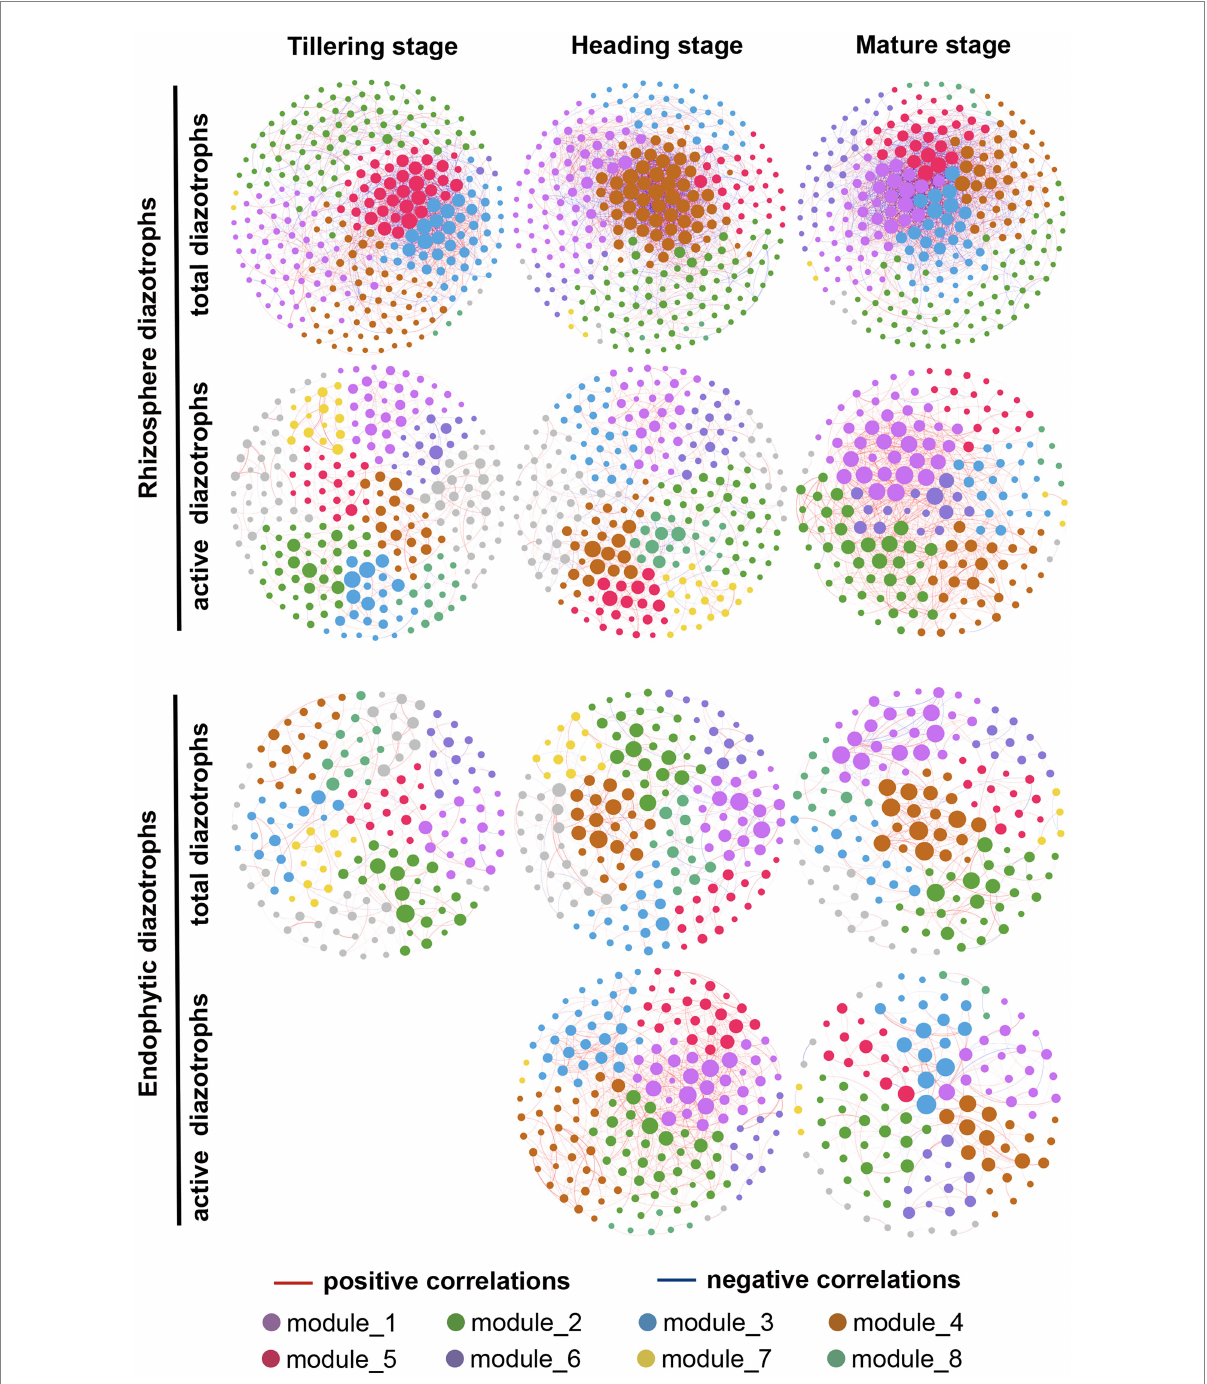
FIGURE 6 Co-occurrence networks of total and active root-associated diazotrophic communities at three growth periods in 2016. Different nodes represent different OTUs. Edges represent Spearman’s correlation relationships. Red solid lines show strong (Spearman’s correlation coefficient r > 0.65) and significant ( p < 0.01) positive correlations between the nodes. Blue solid lines show strong (Spearman’s correlation coefficient r < − 0.65) and significant ( p < 0.01) negative correlations between the nodes. The size of each point represents the node’s weighted degree. Nodes in the eight largest modules are marked with different colors, while other nodes are marked with